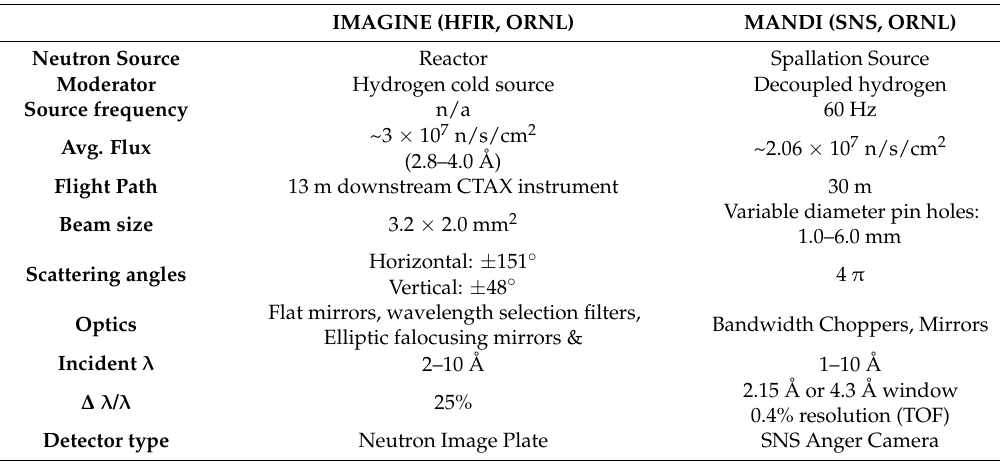
Table 2. Specifications of the neutron protein crystallography instrumentation available to external users at Oak Ridge National